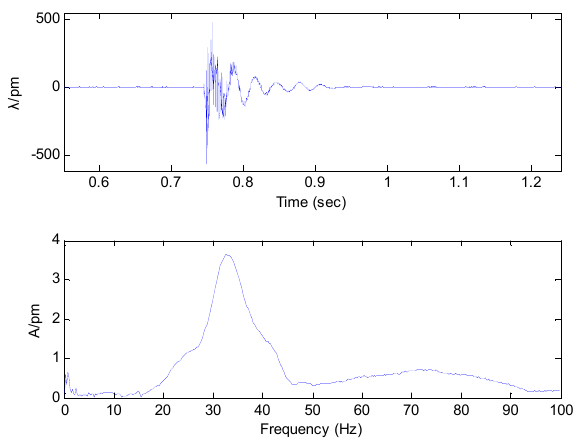
Figure 10. Time domain and spectrum of the micro-vibration sensor.